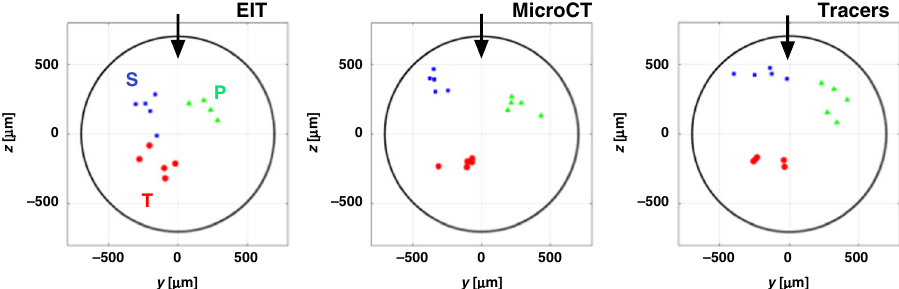
Fig. 5 Centers of mass (CoMs) of fascicles. CoMs derived for all three techniques (a total of N = 5 nerves in 4 animals, including the right sciatic nerve in 3 animals and both left and right nerves in the fourth animal) oriented to position the fi ducial marker (cuff opening) at 12 O ’ clock (black arrow); red/green/ blue dots for tibial, peroneal, and sural fascicles, respectively. The images from the single left-sided nerve were fl ipped in the horizontal plane to allow for combination of all nerves in the same dataset. The nerve boundary is shown as a black circle. There was signi fi cant separation between the fascicles ( p < 0.01, two-way ANOVA). Source data are